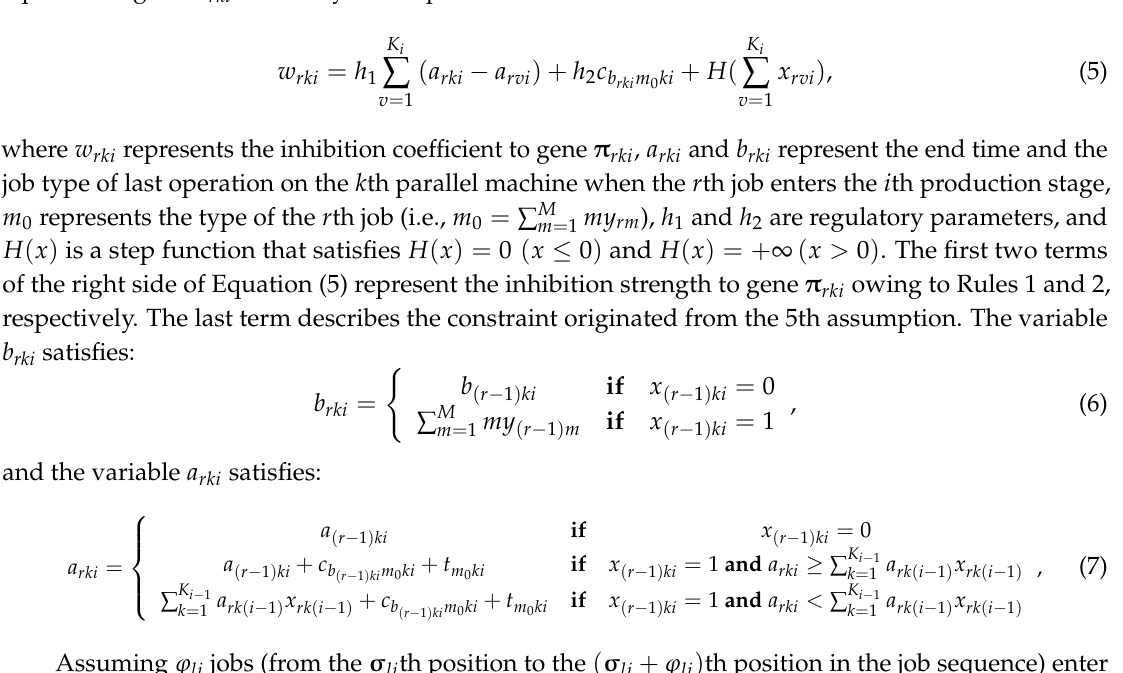
Figure 5. Outline of the GRN-based